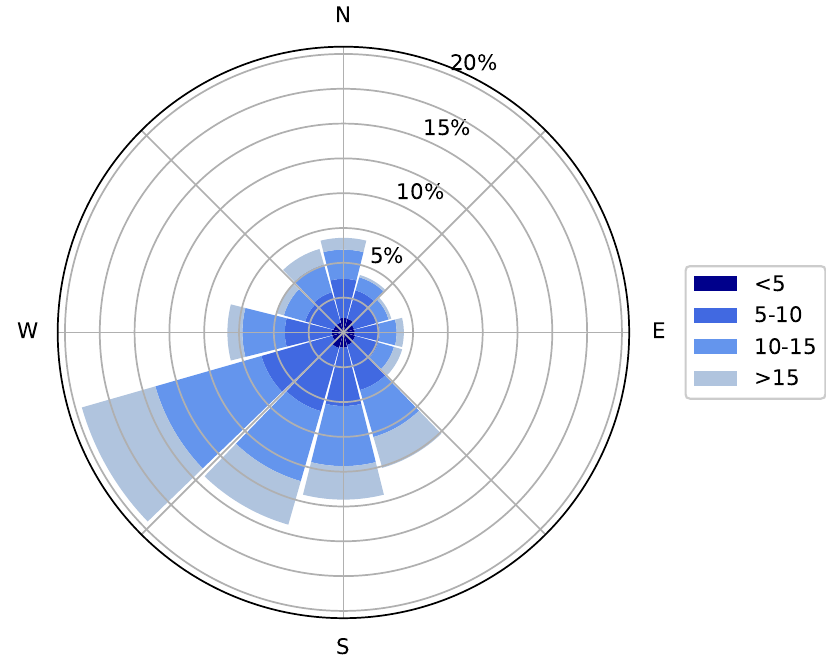
Figure 4. Wind rose for Seagreen farm site [18]. Colours show the range of wind speed U F 0